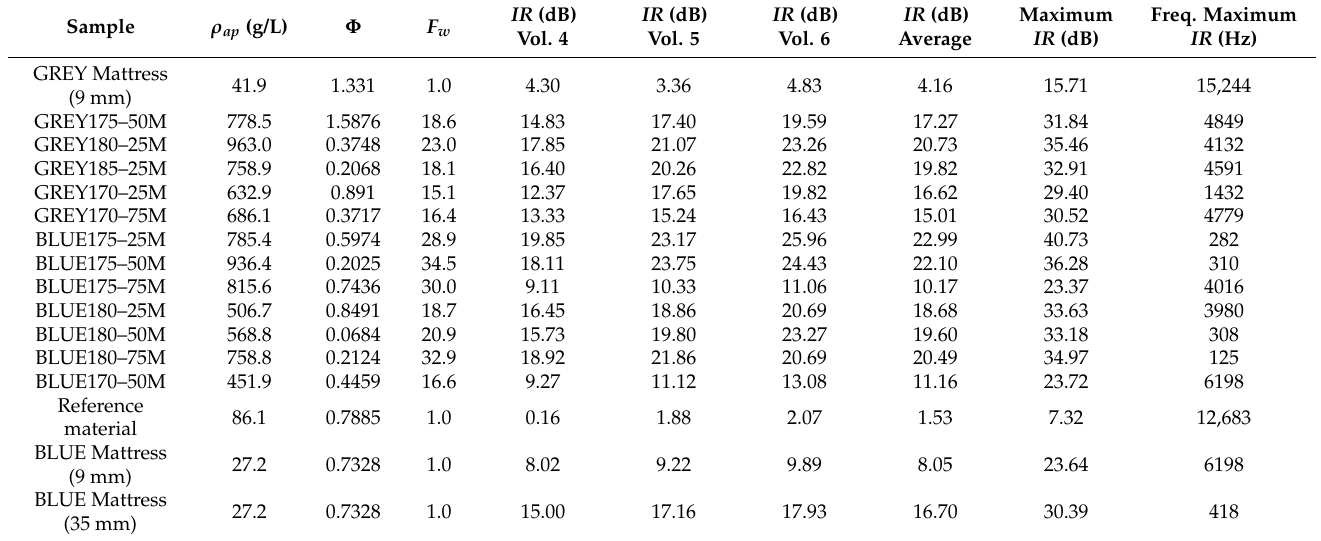
Table 2. Properties of the foams and the briquettes produced, and IR measured at different